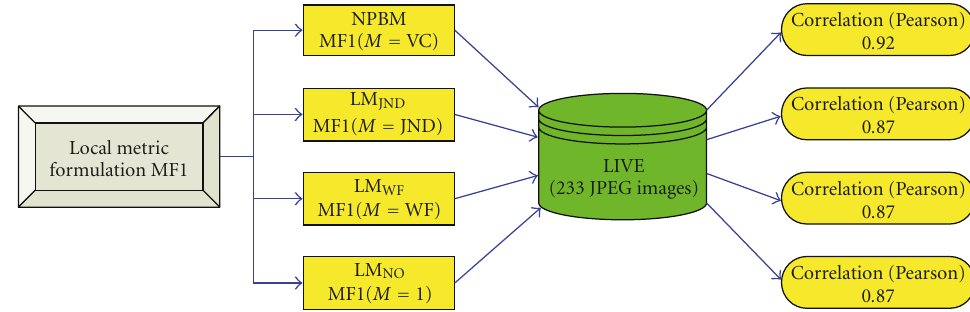
Figure 14: Illustration of the comparison of various HVS models: a blockiness metric (i.e., MF1) having four optional HVS models embedded is tested with the LIVE database, and the performance for each resulting metric is quantified by the Pearson correlation coe ffi cient.